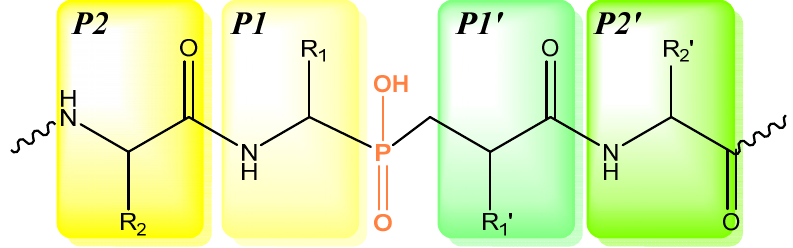
Figure 1. Schematic structure of phosphinic peptide with marked position P2-P2 ′ .